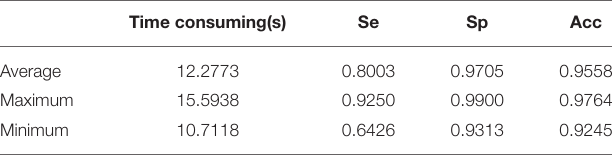
TABLE 4 | Performance of proposed method (STARE).